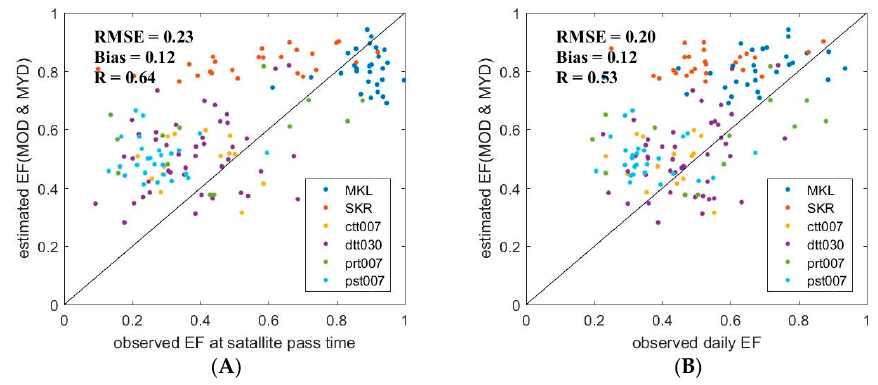
Figure 7. Comparison of estimated EF with ( A ) observed EF at satellite pass time and ( B ) daily EF obtained by ground observation.